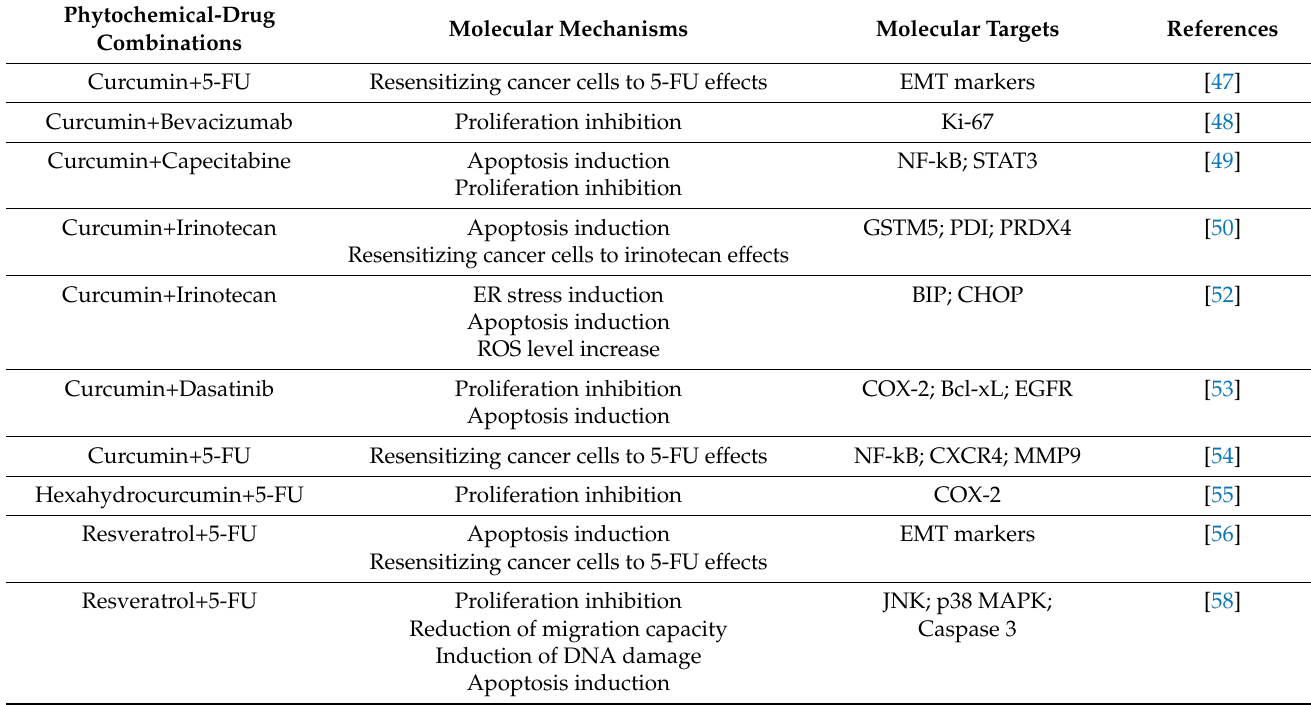
Table 1. Colon cancer